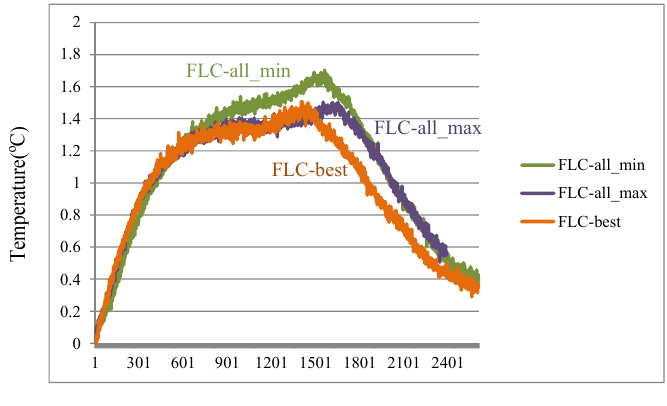
Figure 11. Temperature rise of the proposed FLC-based charging algorithm with different parameter